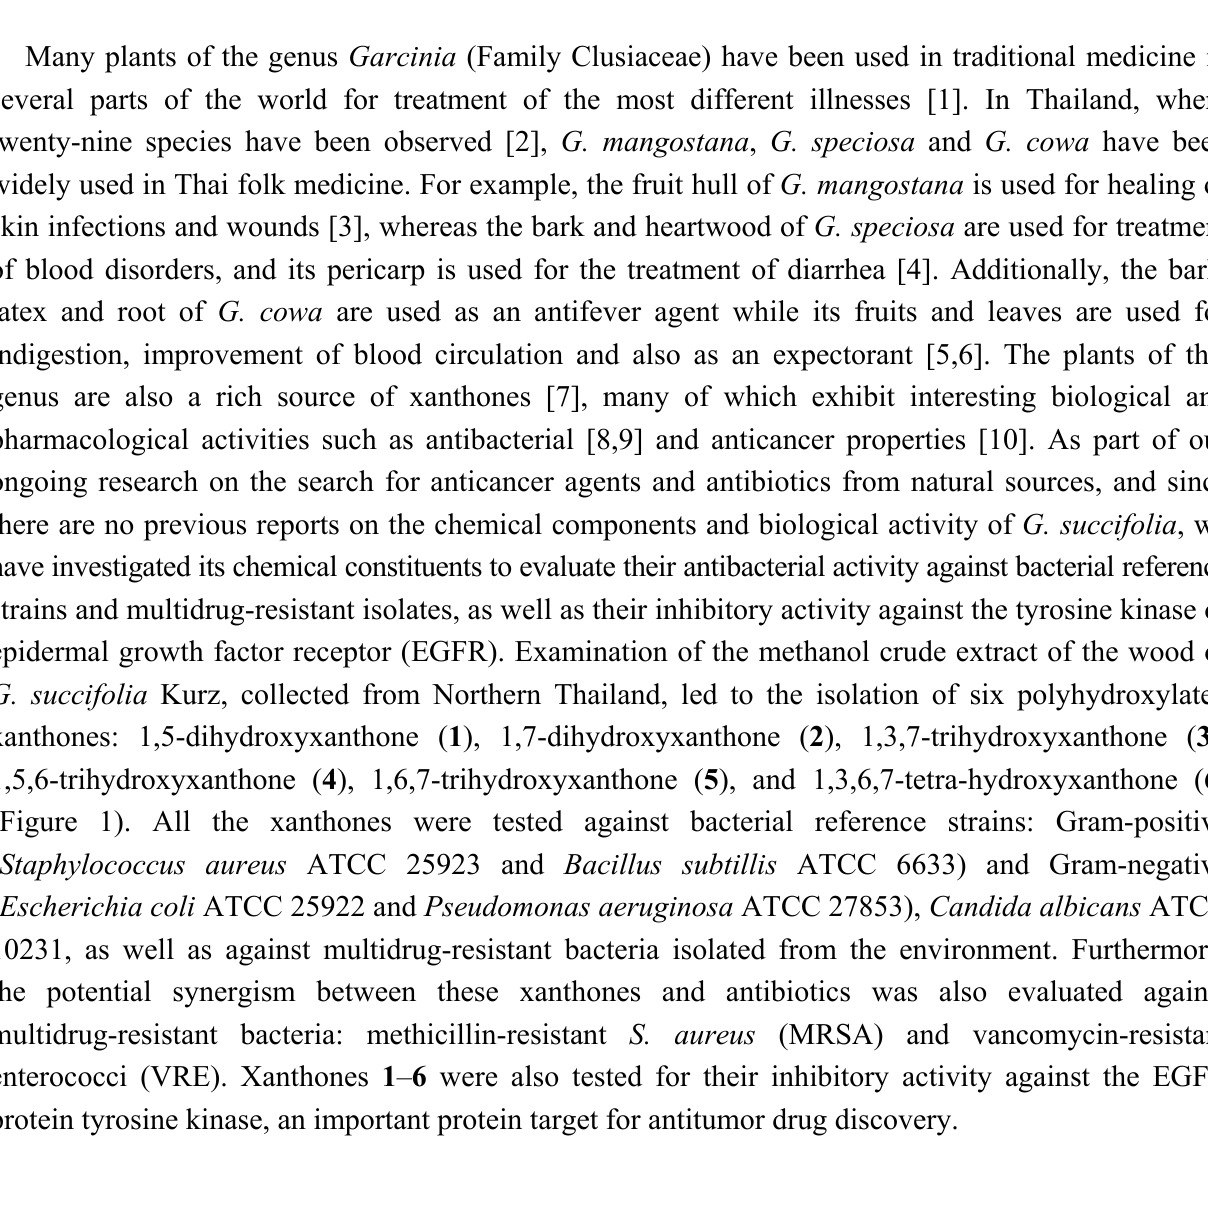
(Figure 1). All the xanthones were tested against bacterial reference strains: Gram-positive ( Staphylococcus aureus ATCC 25923 and Bacillus subtillis ATCC 6633) and Gram-negative ( Escherichia coli ATCC 25922 and Pseudomonas aeruginosa ATCC 27853), Candida albicans ATCC 10231, as well as against multidrug-resistant bacteria isolated from the environment. Furthermore, the potential synergism between these xanthones and antibiotics was also evaluated against multidrug-resistant bacteria: methicillin-resistant S. aureus (MRSA) and vancomycin-resistant enterococci (VRE). Xanthones 1 – 6 were also tested for their inhibitory activity against the EGFR protein tyrosine kinase, an important protein target for antitumor drug